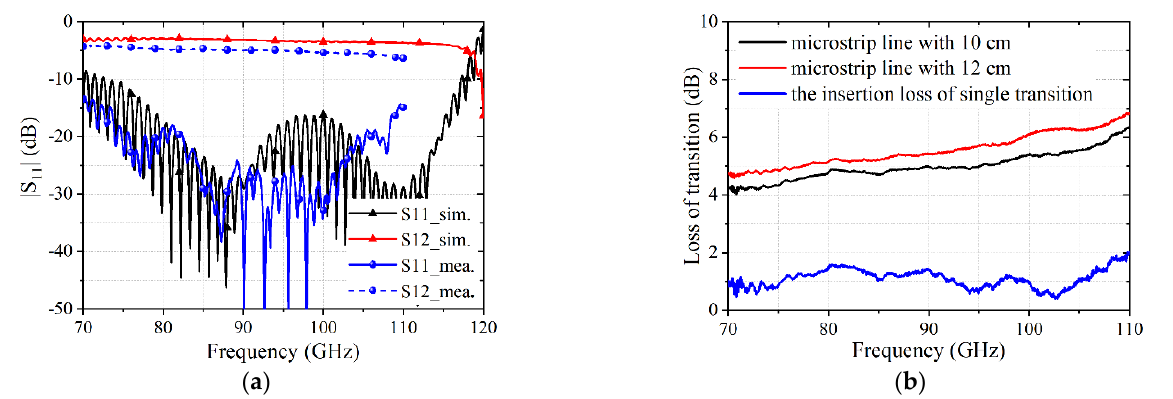
Figure 10. The results of the proposed back-to-back transition. ( a ) Simulated and measured S-parameters. ( b ) The loss of transition with different lengths of microstrip line and the calculated insertion loss of single transition.